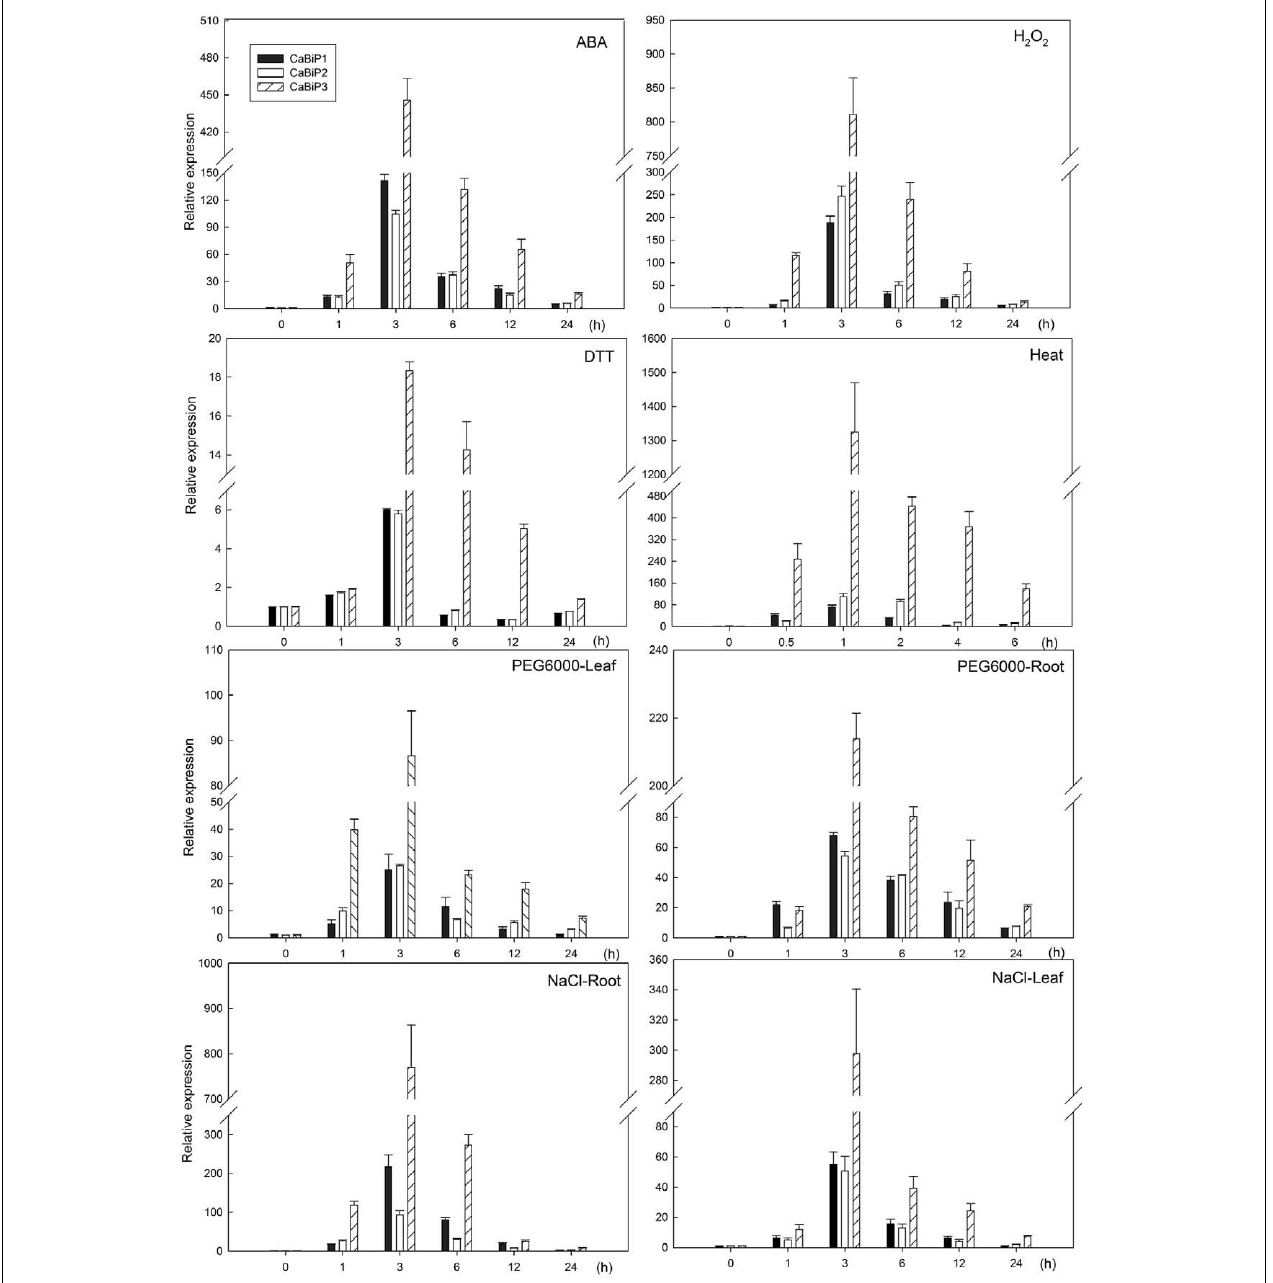
FIGURE 4 | Expression of CaBiP genes following salt, osmotic, heat, ER, ABA, and H 2 O 2 stress treatments. Bars show the standard deviation of expression levels from three biological